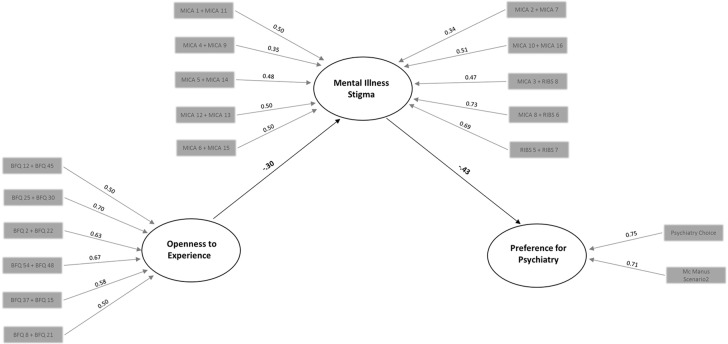
The mediation model of mental illness stigma on the relationship between openness and preference for psychiatry. Statistically significant (p < 0.01) coefficients are shown in bold. Parcels used for the measurement of latent variables together with loading coefficients considered in this investigation are represented by the gray boxes.